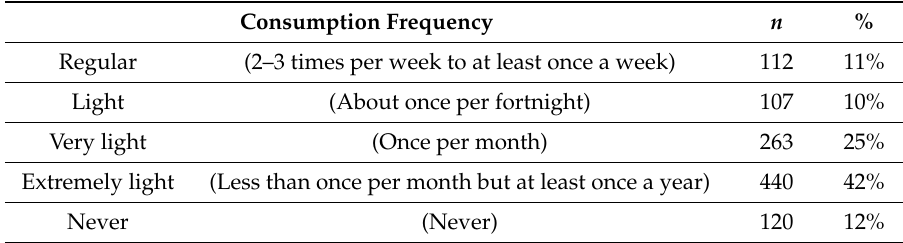
Table 3. Consumption frequency of the sample ( n =